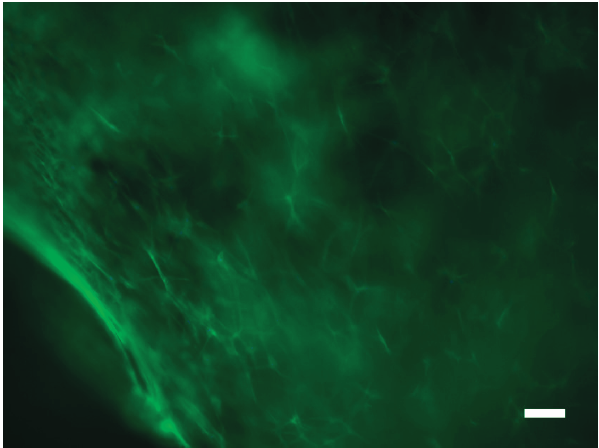
Figure 4. Image of fibroblasts on the surface of the porous silk substrates stained with DAPI (nuclei) and Alexa Fluor 488 ® Phalloidin (actin filaments); scale bar, 100 μ m. Images are representative of at least 3 locations on 3